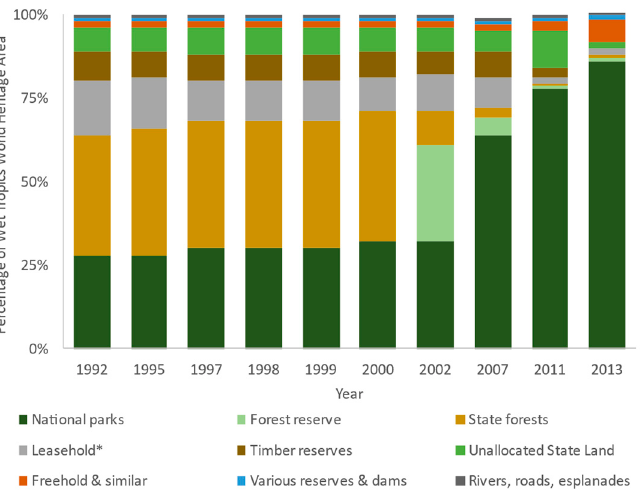
Figure 3. Proportional trends in land tenure in the Wet Tropics World Heritage Area from 1992 to 2013 (data source: Wet Tropics Management Authority).